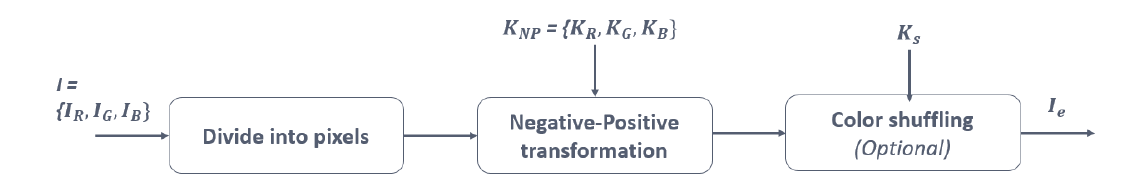
Figure 3. Pixel-based image encryption. © 2019 IEEE. Reprinted, with permission, from